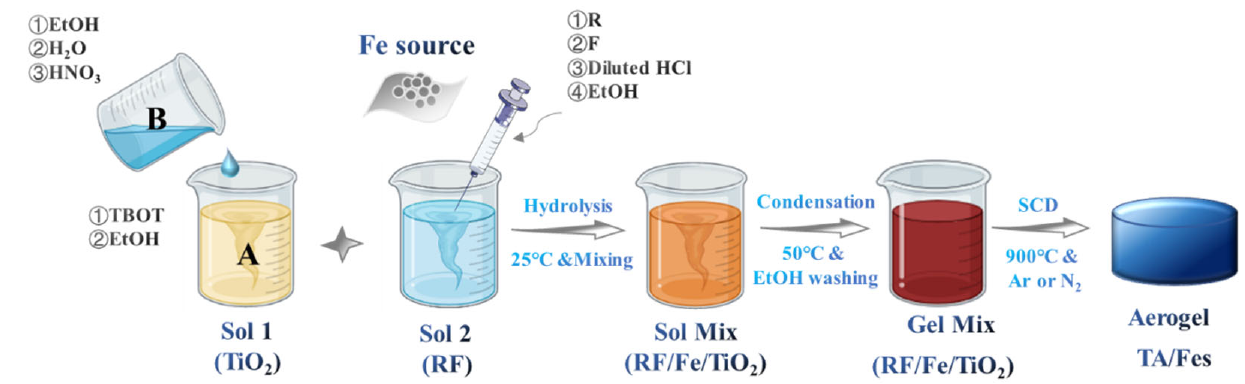
Figure 1. The preparation of titanium oxide-based aerogel catalysts doped by four types of Fe sources.